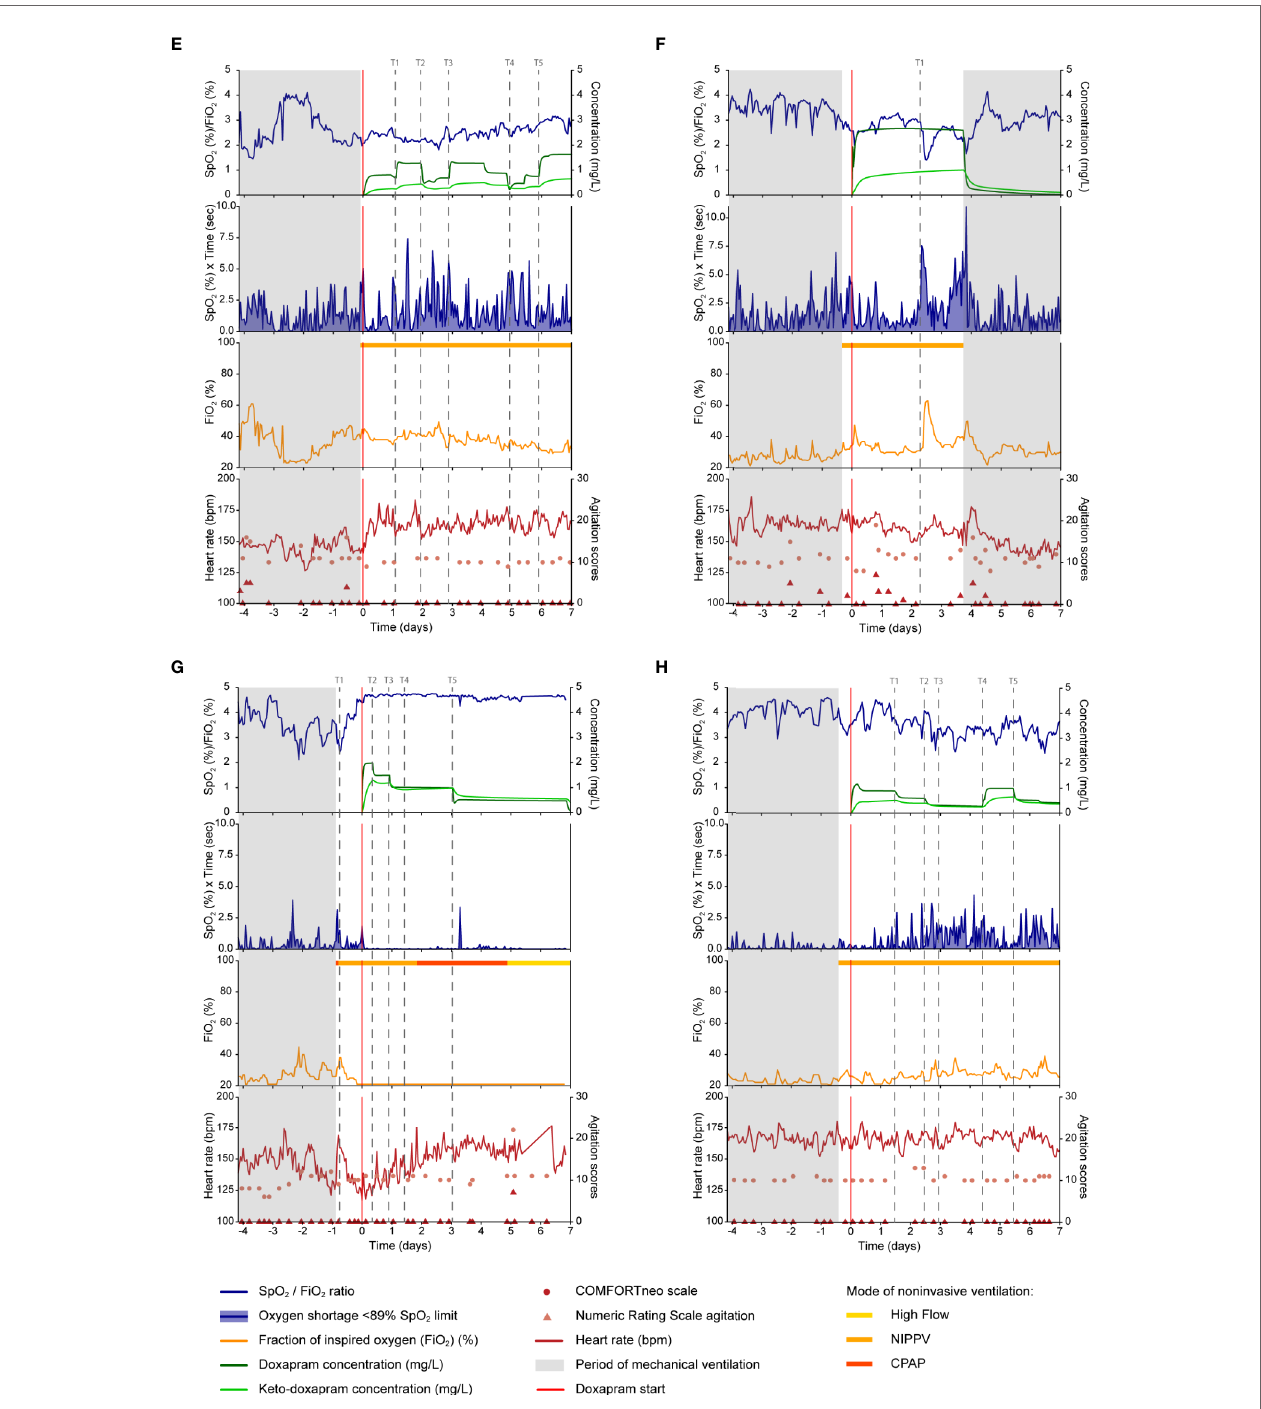
FIGURE 1 | Data on doxapram effect, exposure and ADRs are visualized of the eight selected preterm infants (A – H) . Doxapram effect is re fl ected by the oxygen saturation (SpO 2 ), fraction of inspired oxygen (FiO 2 ), the oxygen shortage <89% SpO 2 limit, and the SpO 2 /FiO 2 ratio. Doxapram and keto-doxapram exposures were simulated from a population pharmacokinetic model. The NRS agitation, COMFORTneo scale, and heart rate re fl ected the adverse drug reactions agitation and tachycardia. Speci fi c time-points were marked (T). ADRs, adverse drug reactions; NRS agitation, Numeric Rating Scale